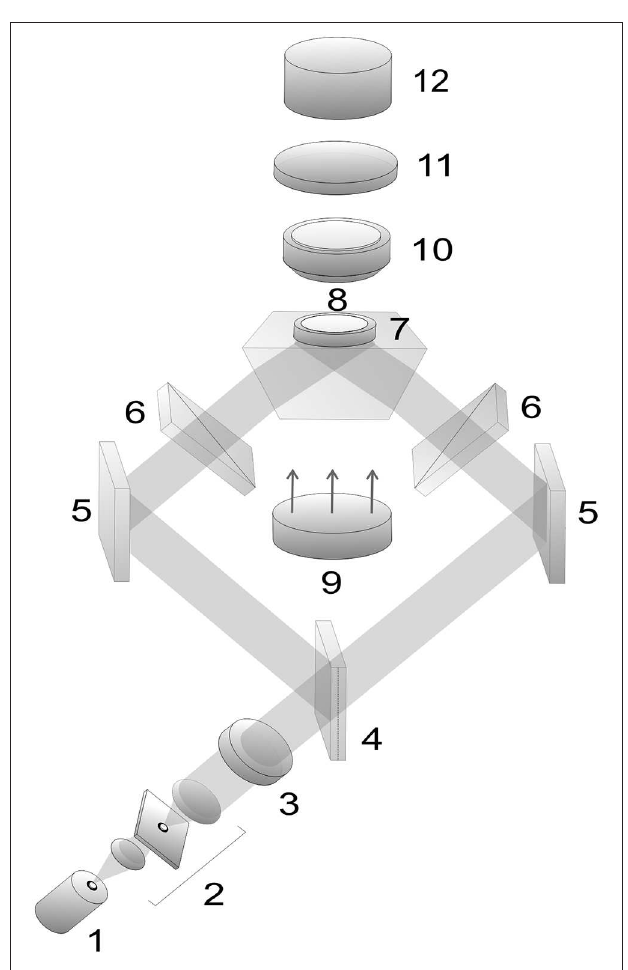
FIGURE 5 | Optical arrangement for study of moving erythrocytes in an evanescent field: 1, laser; 2, beam expander with a spatial filter; 3, quarter-wave plate; 4, beam splitter; 5, mirrors; 6, polarizers; 7, total reflection prism; 8, cuvette with erythrocytes; 9, LED display; 10, micro-objective; 11, light filter; 12,